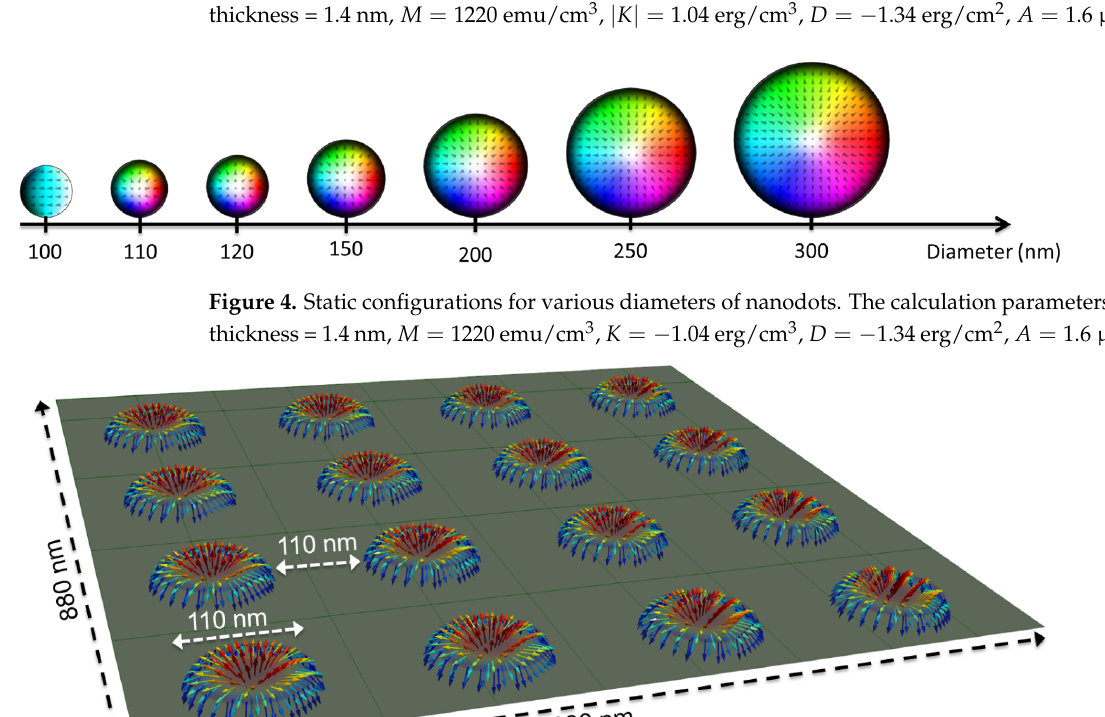
Figure 3. Static configurations for nanodot of 150 nm diameter in the case of K < 0 (left) and K > 0 (right). K < 0 refers to spontaneous in-plane magnetization for a film. K > 0 refers to spontaneous perpendicular magnetization for a film. The calculation parameters are: dot diameter = 150 nm, dot thickness = 1.4 nm, M = 1220 emu/cm 3 , | K | = 1.04 erg/cm 3 , D = − 1.34 erg/cm 2 , A = 1.6 µ erg/cm.